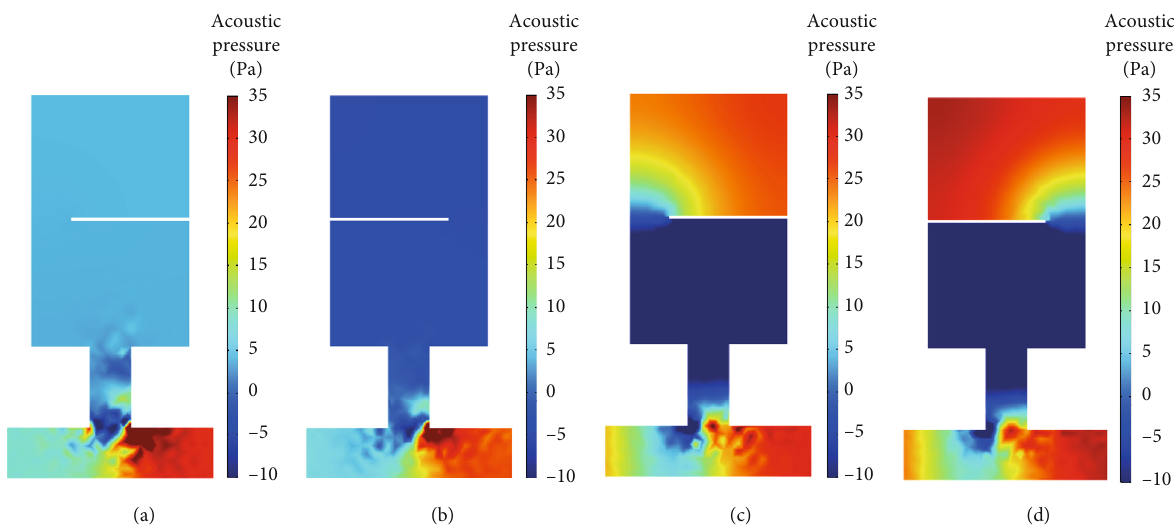
Figure 12: Comparison of the calculated contours of acoustic pressure at the dominant resonant frequency (a, b) and the secondary resonant frequency (c, d), as the rigid ba ffl e is either attached to (a – c) right sidewall or (b, d) left sidewall. Here, M = 0 : 75 D . L p r